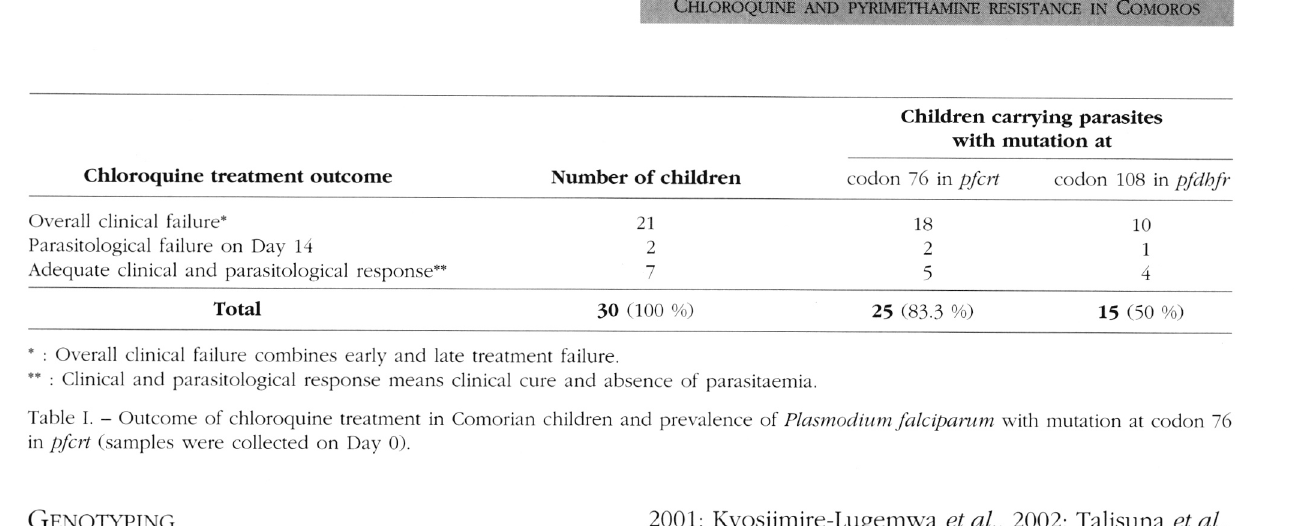
G enotyping The 30 nested PCRs for pfcrt, pfm drl and pfdhfr were successful. All of the examined isolates of P. fa lci­ parum collected on day-0 yielded a pfm dr 1 PCR pro­ duct that was digested with Afl III . This indicated that all isolates contained the pfm dr 1 tyrosine-86 (86Y) mutation. Only two of 30 isolates were mixed i.e. contained in addition to the mutant pfm drl 86Y para­ sites, parasites that had an A fl III-insensitive product.